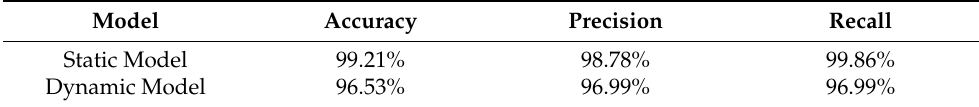
Table 2. Accuracy, precision and recall of the static and dynamic